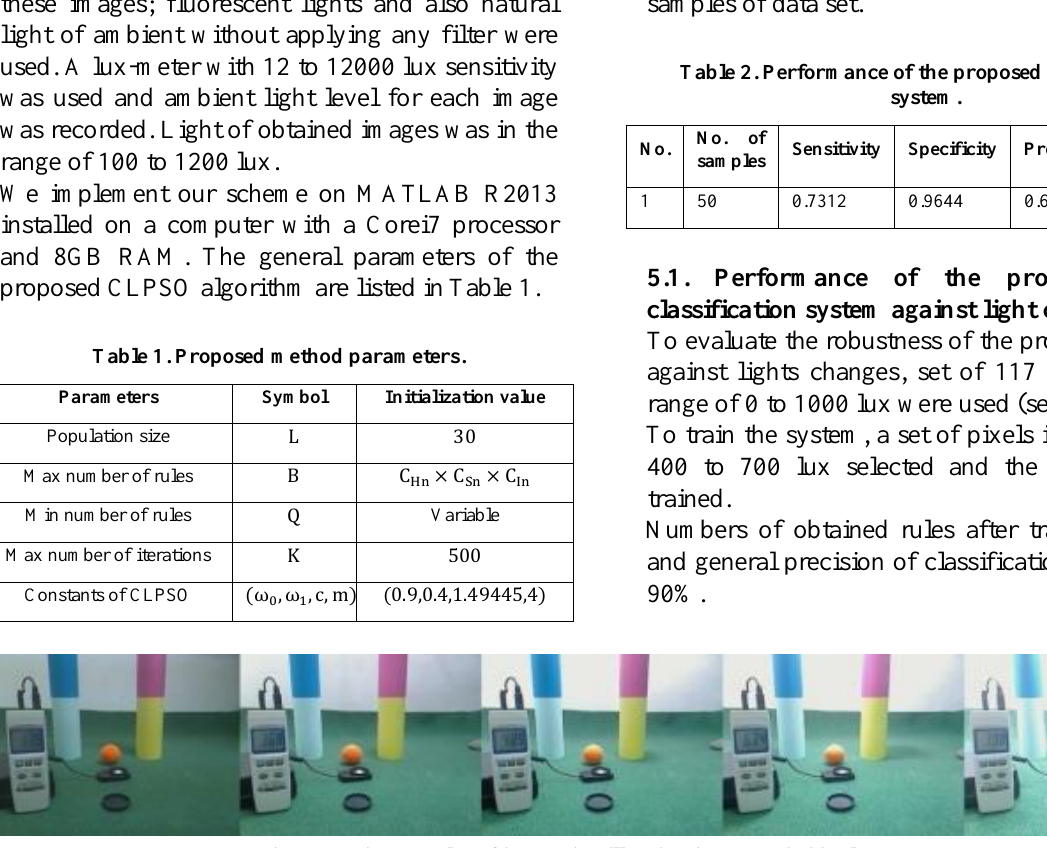
Figure 4. Five samples of increasing illumination recorded by lux